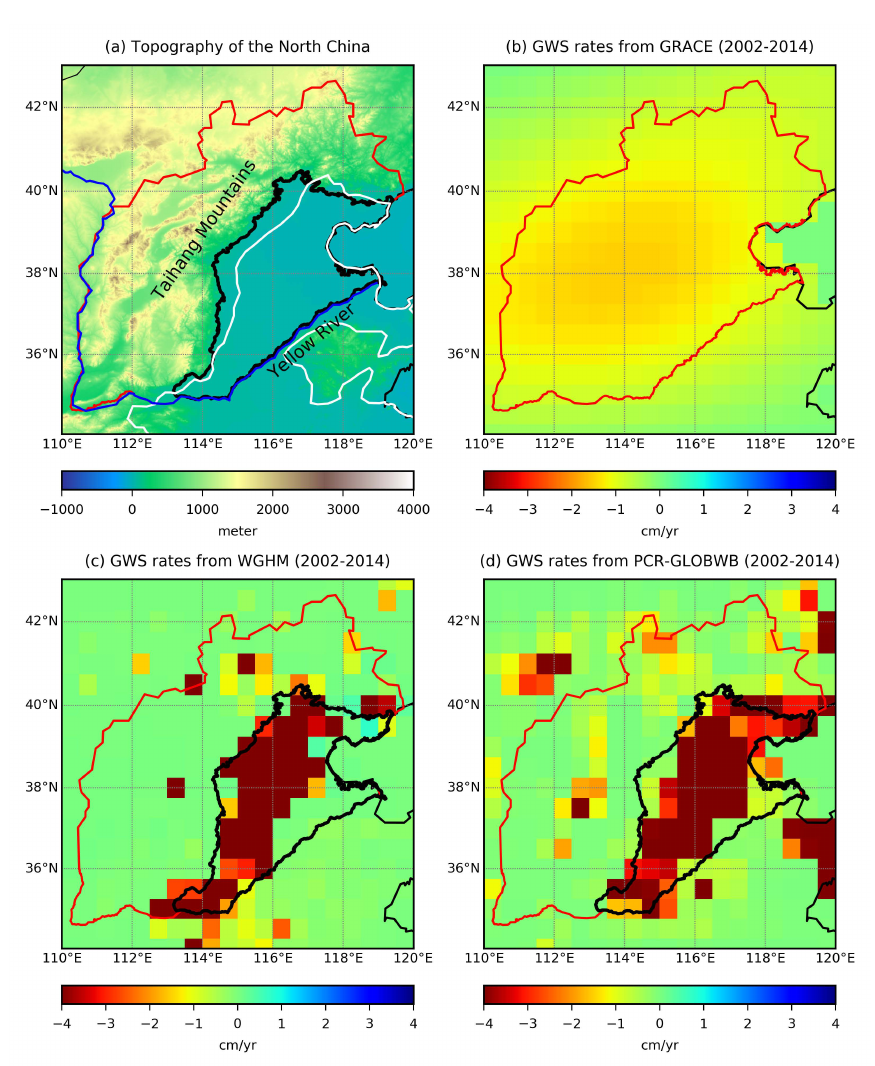
Figure 3. ( a ) Topography of the North China. The black boundary outlines the NCP. The red boundary shows the study region including the whole NCP and mountains in Hebei province and Shanxi province. The white line shows the boundary of the North China Aquifer System, same as Figure 1. The blue line shows the Yellow River. GWS rates from ( b ) GRACE; ( c ) WGHM; and ( d ) PCR-GLOBWB in the North China during